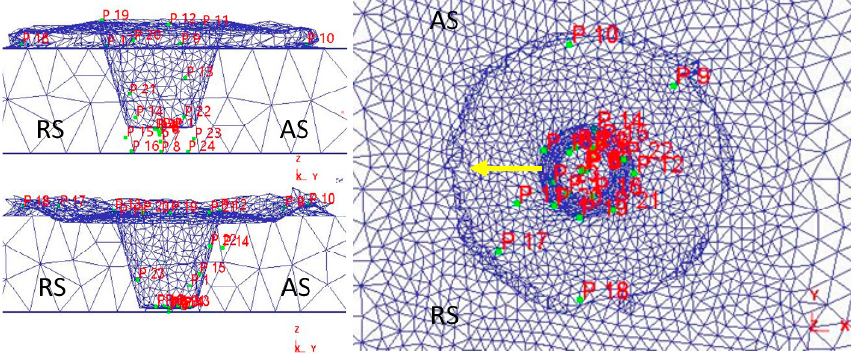
Figure 11. Tool needle internal particle plunging process.